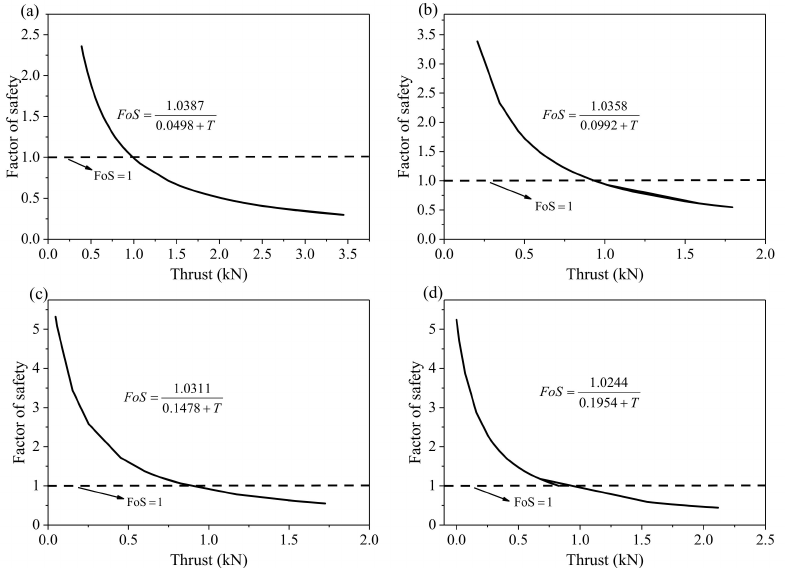
Figure 5. The factor of safety (FoS) is inversely proportional to the thrust. ( a – d ) show the inverse relationship between FoS and thrust for the four experiments.